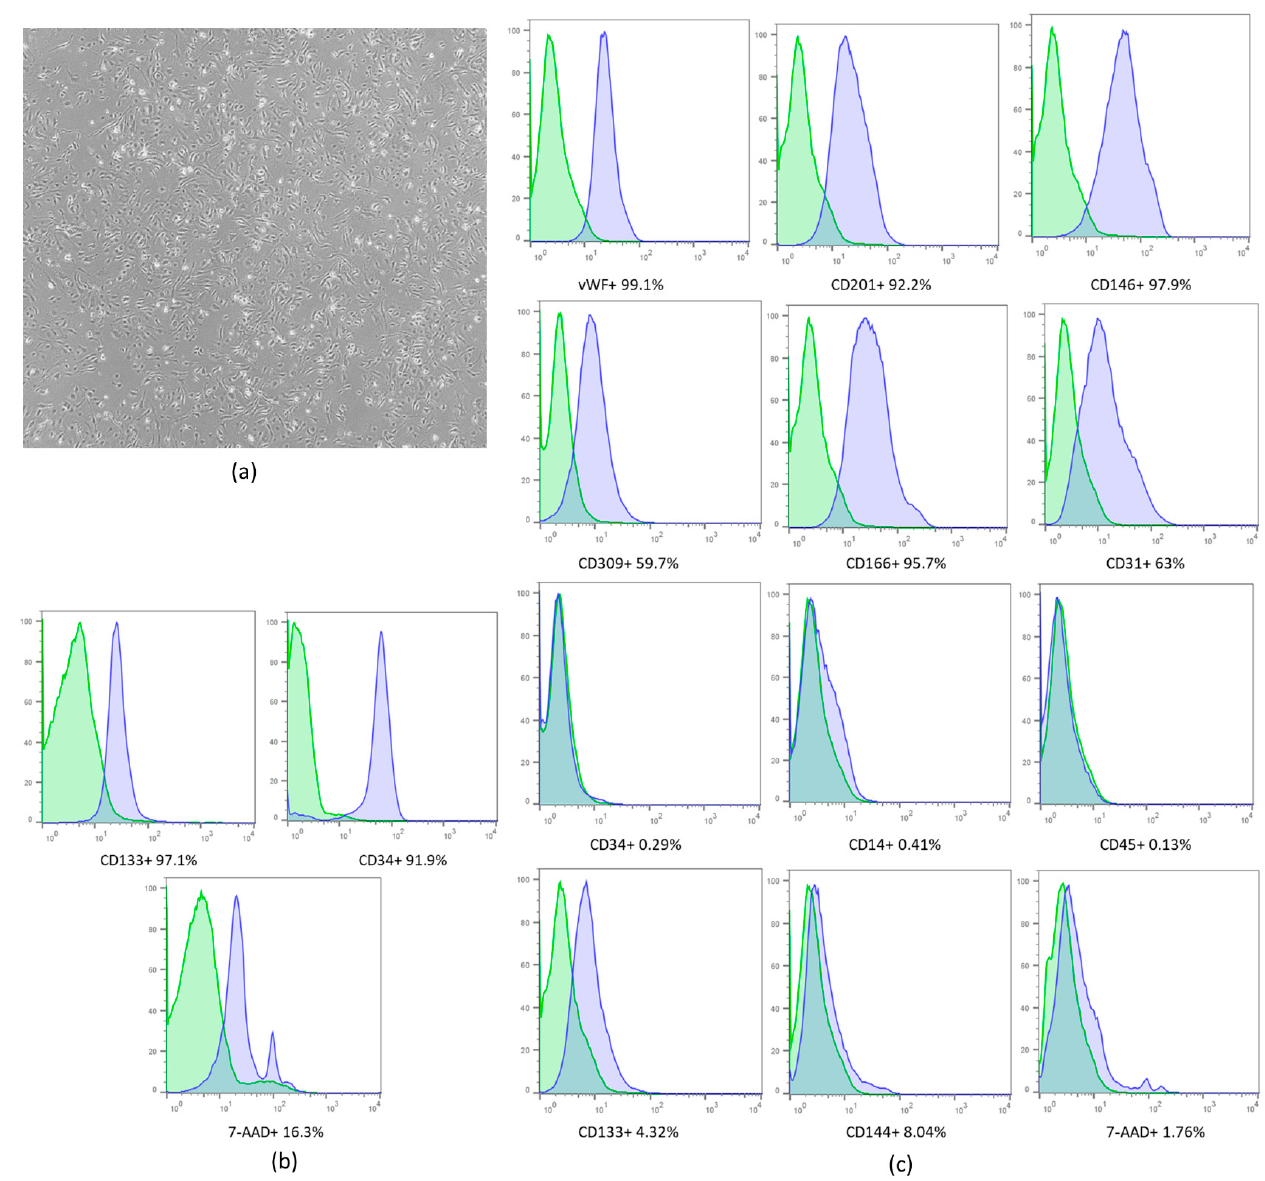
Figure 2. ( a ) Culture of EPCs. Immunophenotypic analysis by flow cytometry. ( b ) Purified CD133 + cell characterization (representative set from one donor). ( c ) Expanded CD133 + cell characterization. The blue histograms indicate the percentage of the population that was positive for each antibody, while the green histograms indicate the isotype controls. For 7-AAD analysis and autologous control was used. Microscope objective: 5×. The results are expressed as percentages (%).